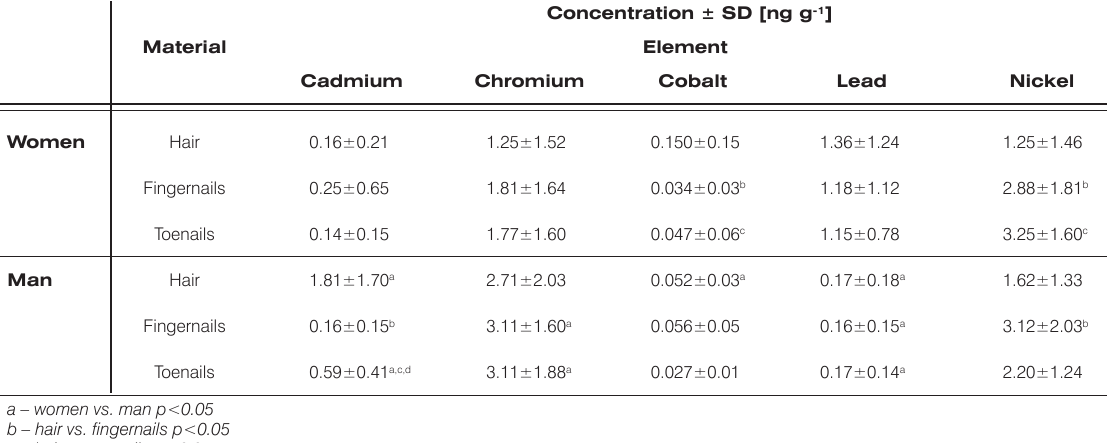
Table 5. Mean concentration of metals interested from toxicological point of view in hair and nails of healthy volunteers (24 women; 18